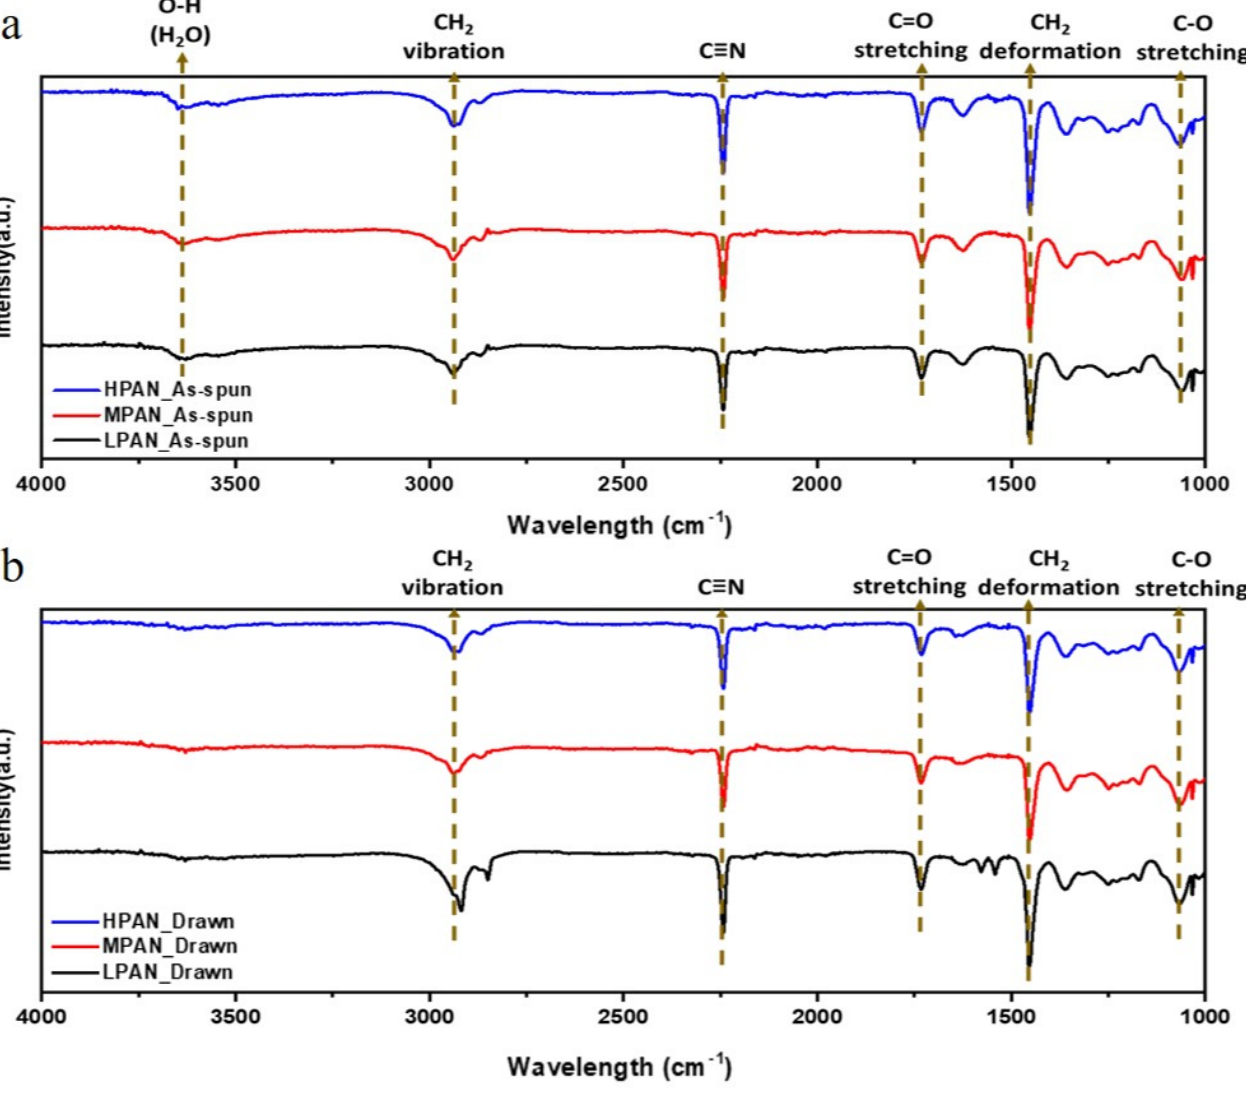
Figure 6. FT-IR spectra of P(AN-co-MA) precursor fibers with different molecular weights; ( a ) as-spun fibers and ( b ) drawn